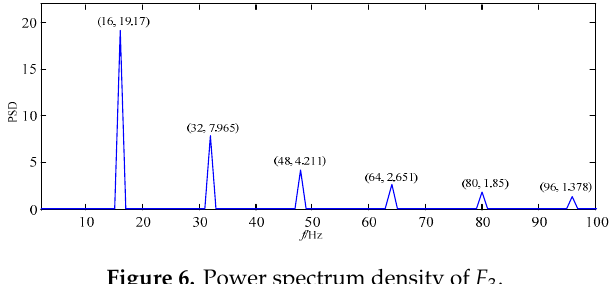
Figure 6. Power spectrum density of F 3 .